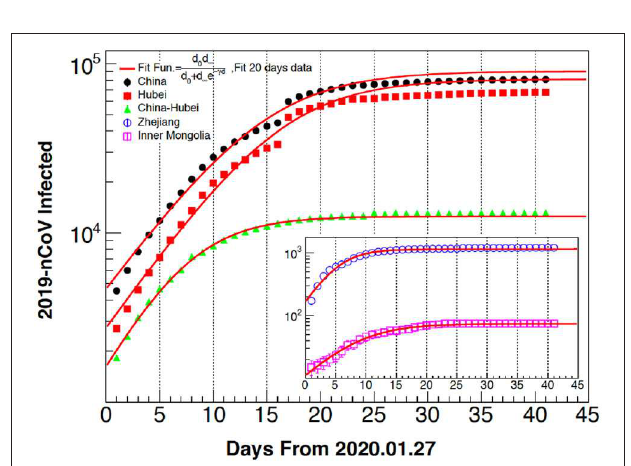
FIGURE 2 | Patients who tested positive for COVID-19 with function of time starting from January 27, 2020. Each region case is clearly indicated in the figure together with the fitting function. Model and theory saturate at long times which implies the epidemic is over. The model suggests 25 days for saturation, shorter than for SARS in Figure 1 (around 50 days).